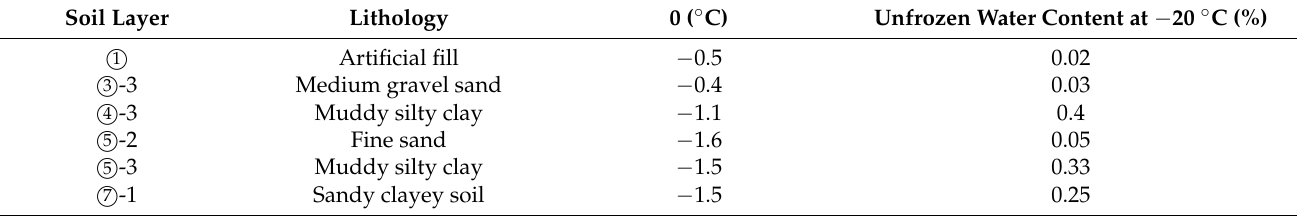
Table 2. The freezing temperature of the soil layer and unfrozen water content at − 20 ◦ C.